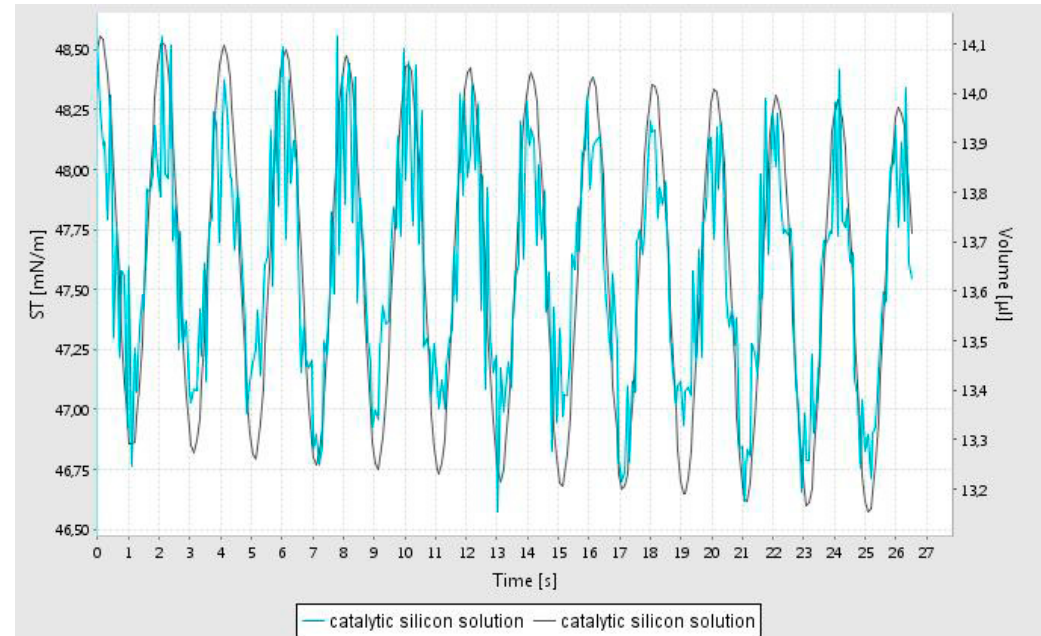
Figure 1. Variation of pendant drop volume (smooth curve) and the computed surface tension (irregular curve) of the silica support precursor dispersion (Bindzil CC30) as a function of time for the measurement of surface rheology.